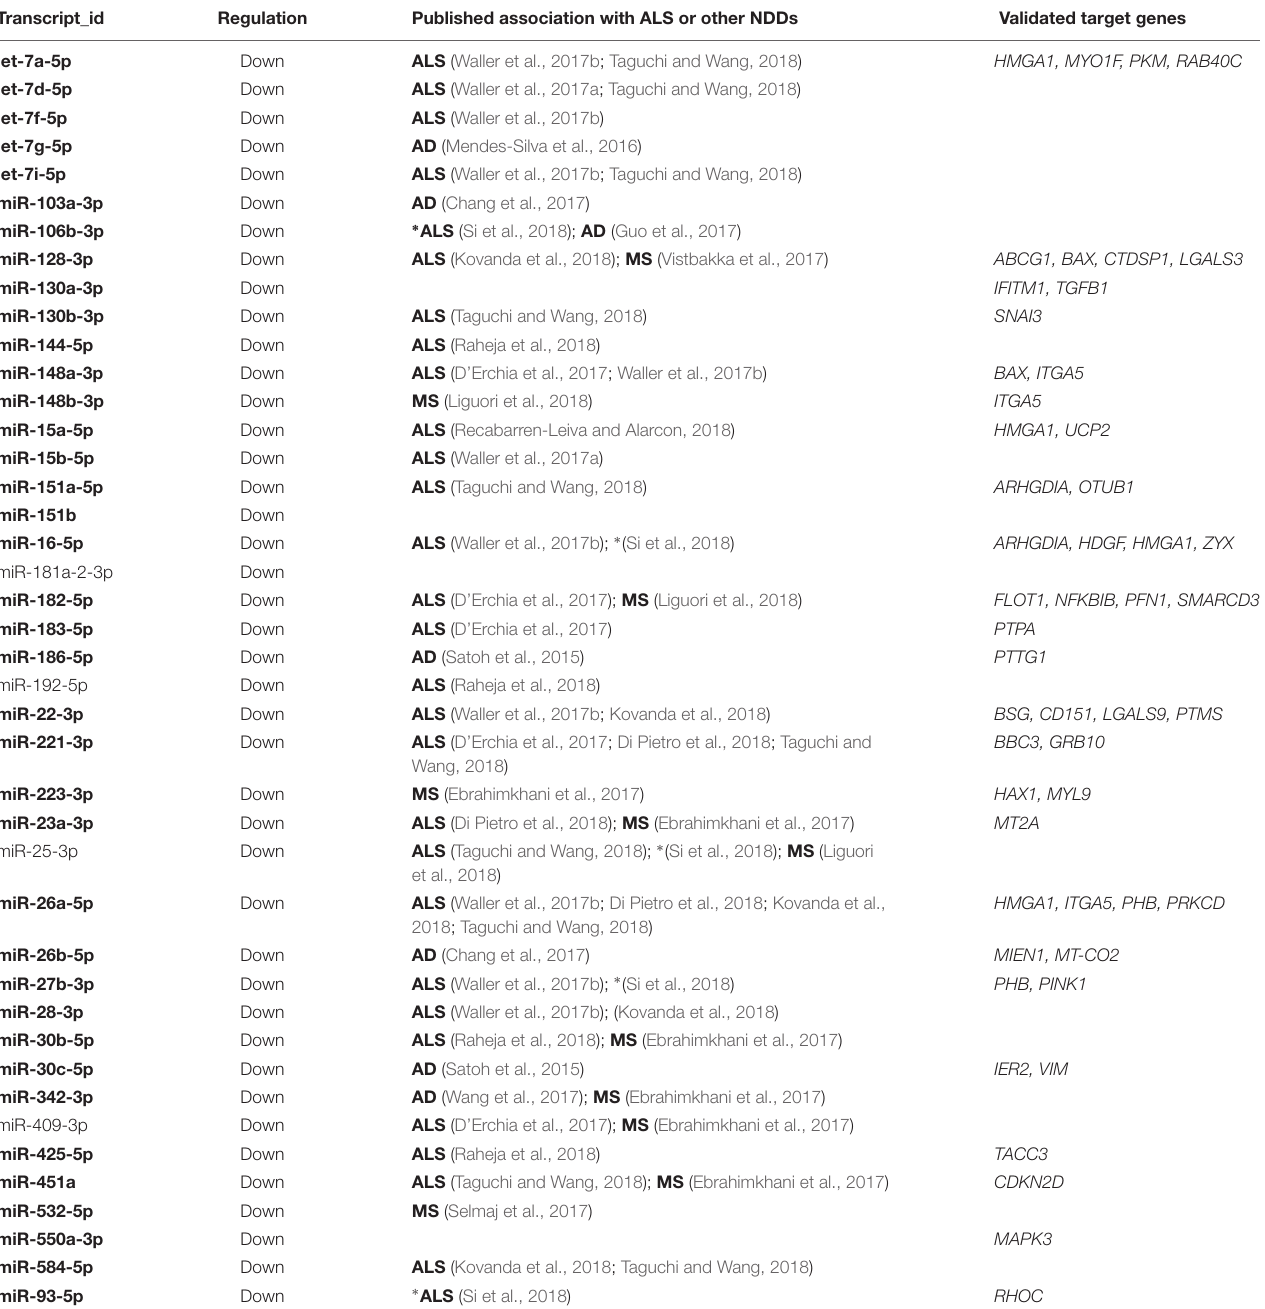
TABLE 2 | miRNAs/mRNAs